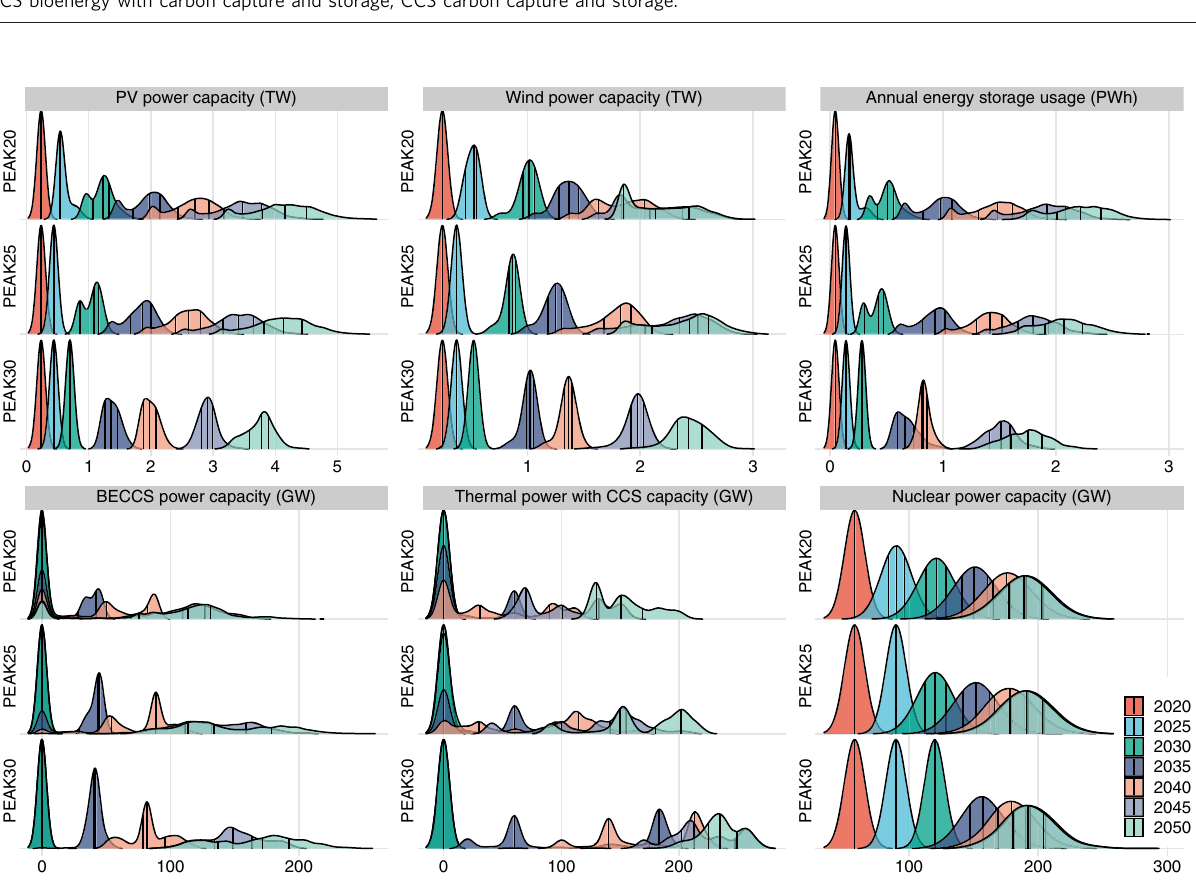
Fig. 4 Uncertainty analysis of the development of promising technologies. a The PV power installed capacity (unit: TW). b The three most critical uncertain parameters for PV power. c The wind power installed capacity (unit: TW). d The three most critical uncertain parameters for wind power. e The annual energy storage technology usage (unit: PWh). f The three most critical uncertain parameters for annual energy storage technology usage. g The BECCS power installed capacity (unit: GW). h The three most critical uncertain parameters for BECCS power. i The thermal power with CCS installed capacity (unit: GW). j The three most critical uncertain parameters for thermal power with CCS. k The nuclear power installed capacity (unit: GW). l The three most critical uncertain parameters for nuclear power. The box plot shows the fi rst quantile, intermediate range (IQR), and third quantile of all the results, where the data range within 1.5 times the IQR is denoted with whiskers. The thick blue line represents the pathway of the NDC scenario, and the thick gray line represents the pathway for the intermediate case in each scenario. The divergent color from blue to green re fl ects the increasing stringency of the cumulative carbon budget. The cumulative CO 2 parameter corresponds to the absolute value of China ’ s cumulative carbon budget for 2010 – 2050. The scatter plots depict the relationship between the development of each technology and uncertain input parameters, as fi tted by a linear function. Three parameters with signi fi cant impacts among the fourteen uncertain input parameters are shown for each technology. The remaining results are shown in Supplementary Figs. 5 – 10. The variables (except for the cumulative carbon budget) represent multiples of the intermediate cases for each scenario. The intermediate cases of PEAK20, PEAK25, and PEAK30 are denoted with square, plus, and multiplication signs, respectively. PV photovoltaic, BECCS bioenergy with carbon capture and storage, CCS carbon capture and storage.